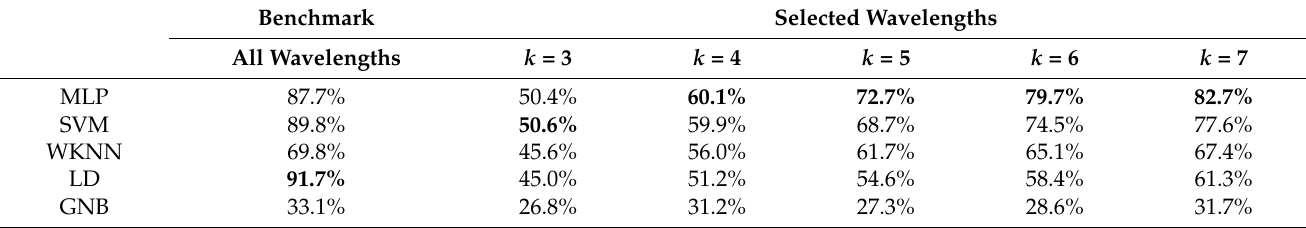
Table 3. Single-mode classification accuracies (4-fold cross-validation) for the VNIR reflectance data. Benchmark